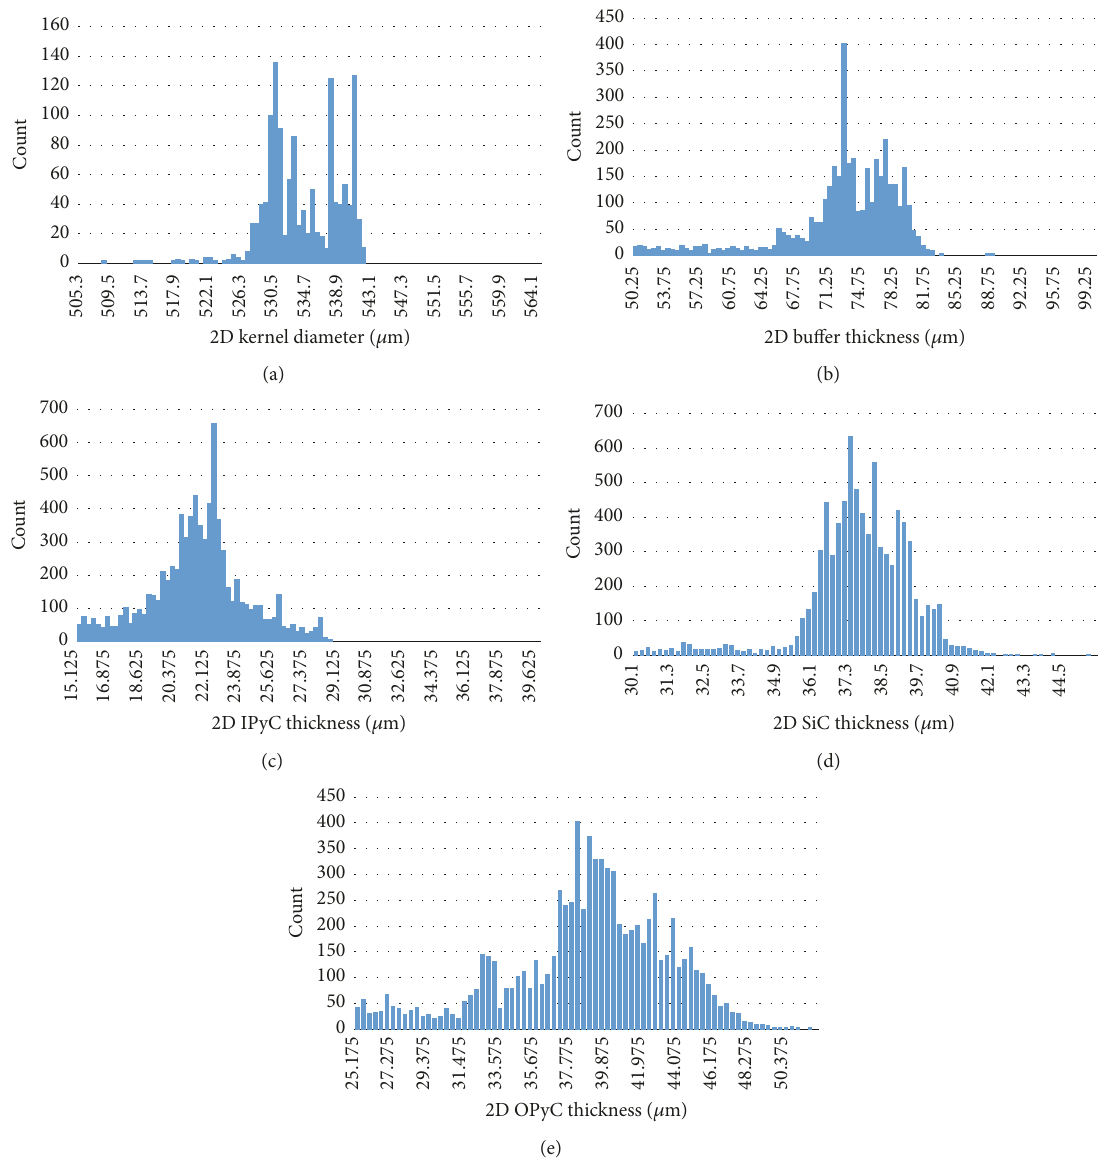
Figure 8: Diameter/thickness distribution of (a) kernel, (b) buffer, (c) IPyC, (d) SiC, and (e) OPyC with 2D